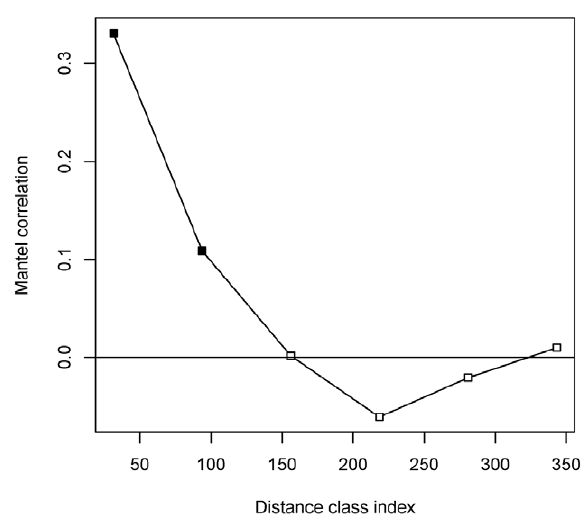
S1. – Mantel correlogram for the abundance data of aggrega- Fig. S2. – Species accumulation curve for the locations with density tions as a function of the geographic distance classes among the at or above the threshold 10.5 sea pens/haul of F. quadrangularis study locations. The black squares indicate significant spatial and correlation.